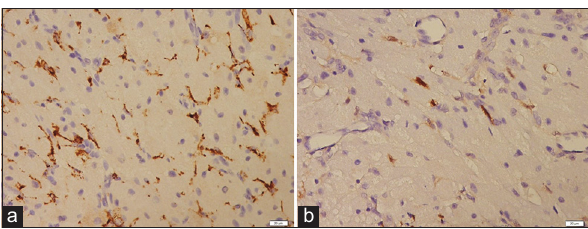
a Figure 2 : (a) S-100 negative cells with uniform eosinophilic granules cytoplasm, uniform nuclei, and no significant nucleoli. (b) CD68 negative cells with uniform eosinophilic granules cytoplasm, uniform nuclei, and no significan nucleoli